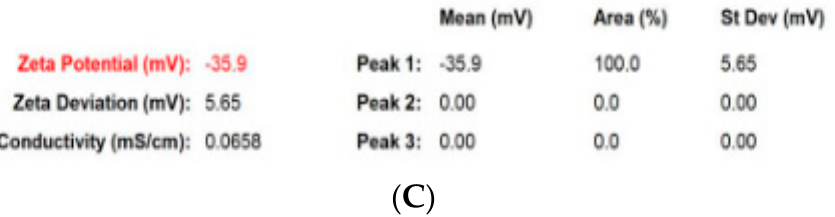
Figure 2. Particle size of the 5FU PLNs-11. Data show ( A ) particle distribution, ( B ) size distribution by volume, and ( C ) Zeta potential distribution. Figures demonstrate better polydispersity and narrow distribution, Z average size in nanometer range and zeta potential ensuring stability.